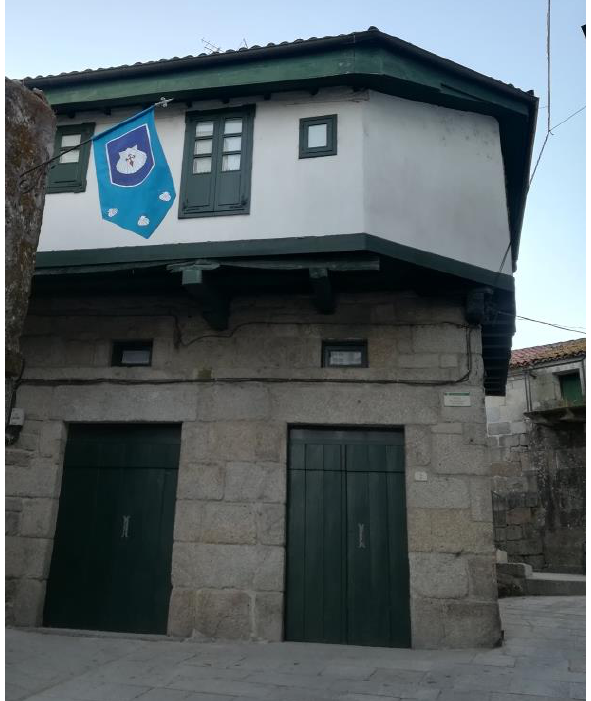
Figure 3. Medieval typology house in the city of Ribadavia, with a ground floor of stone and a half-timbered with earth first floor. Source: